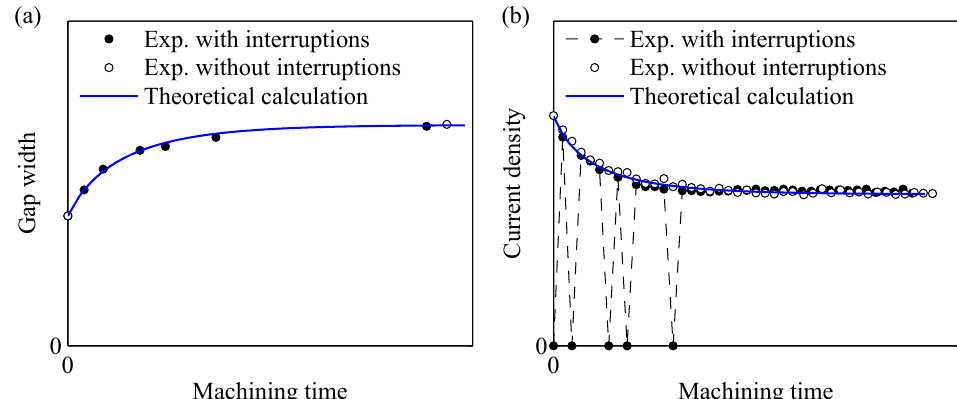
Figure A1. Evolution of the gap width (panel( a )) and the current density (panel( b )) in an ECM experiment at constant feed rate compared with theoretical computations based on the potential model. (The scales are omitted due to reasons of non-disclosure).